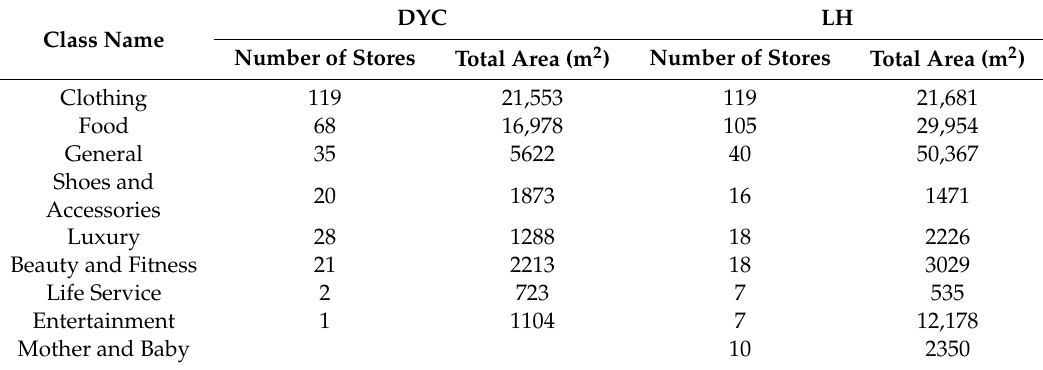
Table 1. Statistics of numbers of stores and total areas for store classes in DYC and